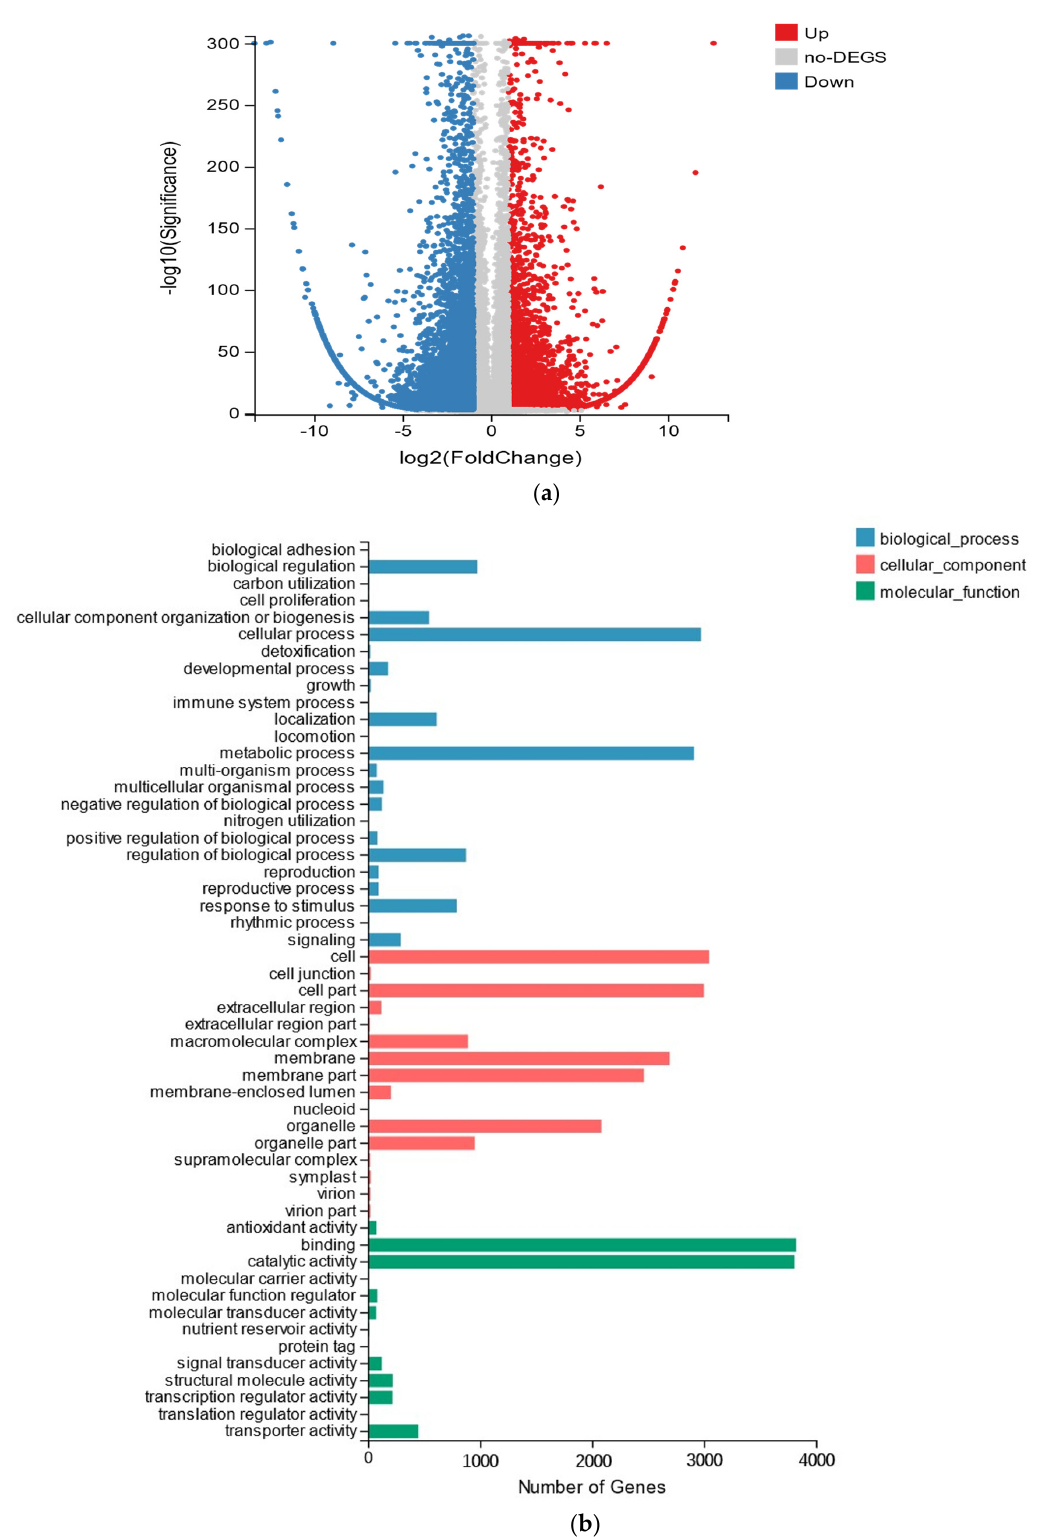
Figure 3. ( a ) Differential gene distribution volcano map of the control group and domesticated R. chrysanthum , red represents up-regulated DEGs, blue represents down-regulated DEGs, and grey represents non-DEGs; ( b ) Functional classification of DEGs based on GO, the left Y -axis represents GO terms, and the X -axis represents the number of DEGs.